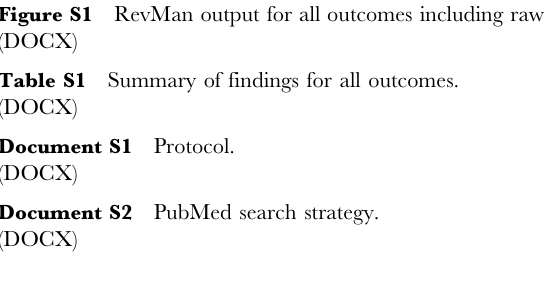
Figure S1 RevMan output for all outcomes including raw data. Table S1 Summary of findings for all